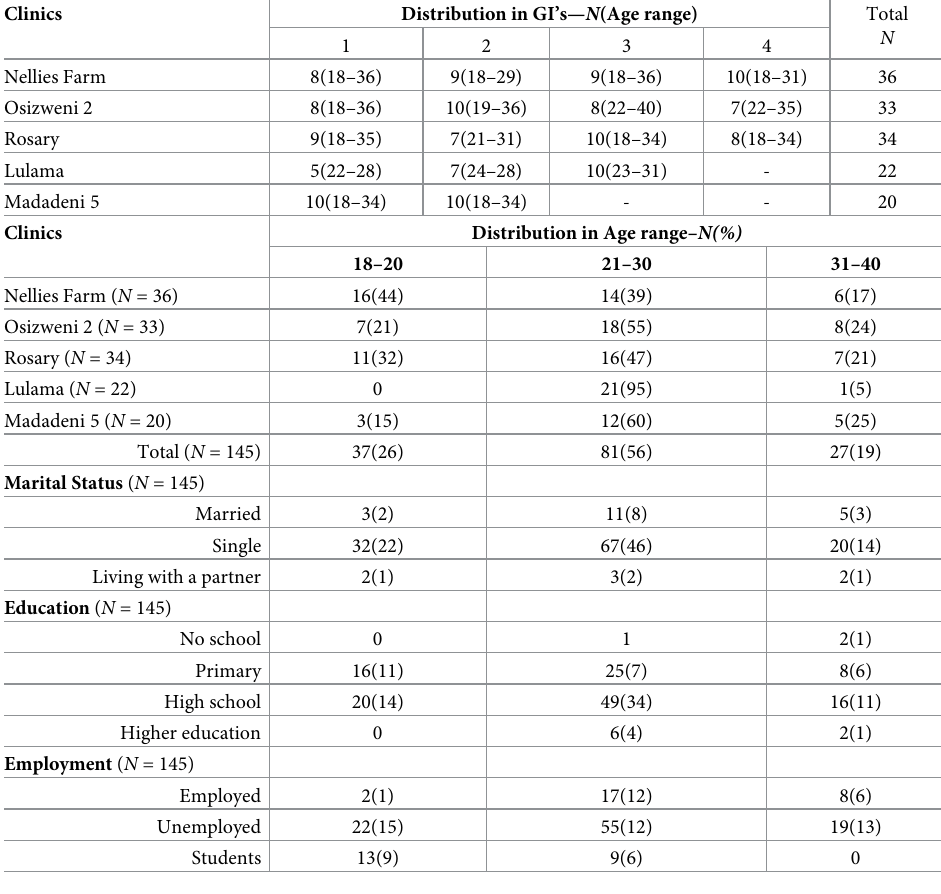
Table 1. Characteristics of